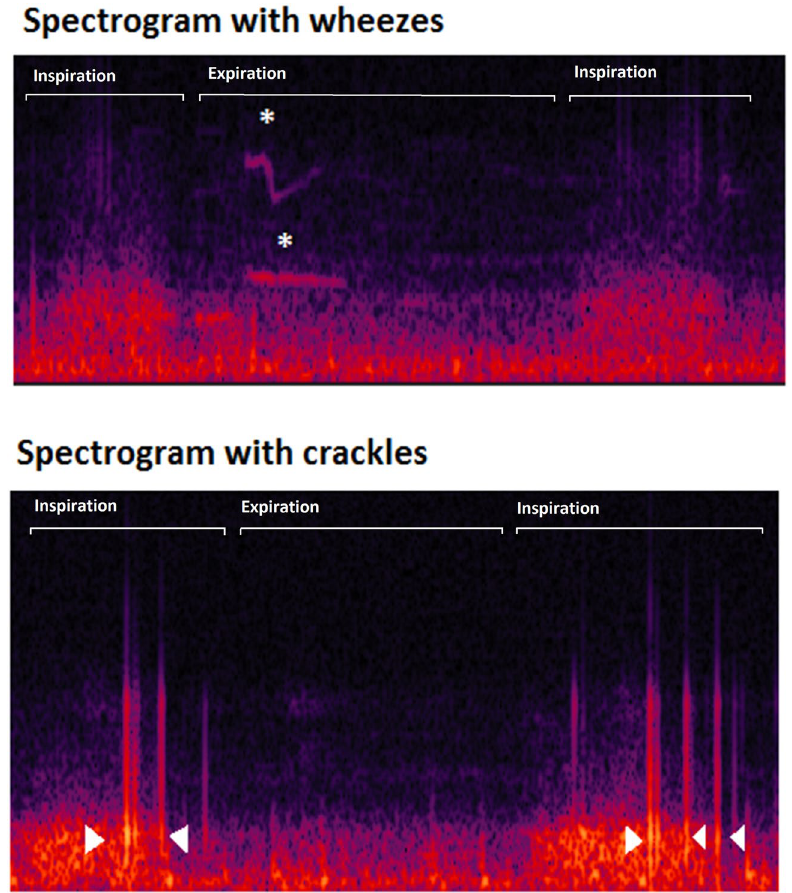
Figure 1. Examples of spectrograms of lung sound recordings showing the presence of wheezes (stars) and crackles